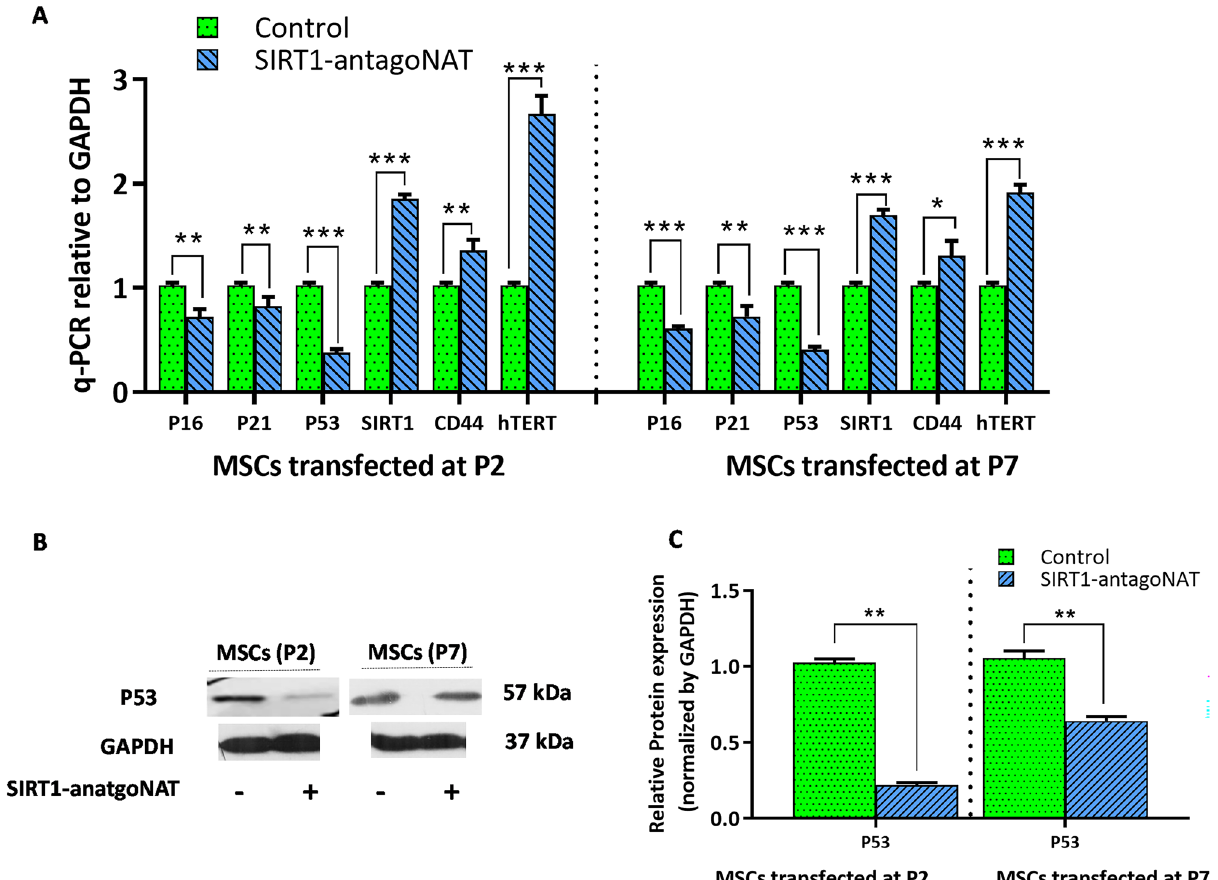
Figure 5. Senescence associated molecular alterations are reversed in MSCs following knockdown of SIRT1-NAT. ( A ) Bar graph showing the relative expressions of P53, P21 and P16 (tumor suppressor genes which characteristically upregulate in senescent cells) as well as that of hTERT and CD44 (which downregulate in senescent MSCs) determined by RT-qPCR. Transfection of SIRT1-antagoNAT in P2 and P7 MSCs downregulated P53, P21 and P16 and upregulated hTERT and CD44 compared with controls. ( B ) Representative immunoblots showing the reduced expression of P53 protein in MSCs transfected with SIRT1- antagoNAT compared with controls. Blots of the GAPDH presented here are the same blots shown in Fig. 2B. Full length blots including P53 bands are presented in supplementary Fig. 2, ( C ) Bar graphs quantifying the Western blot data represented in B. Data are expressed as mean ± SD (n = 3). * p < 0.05, ** p < 0.01, *** p <